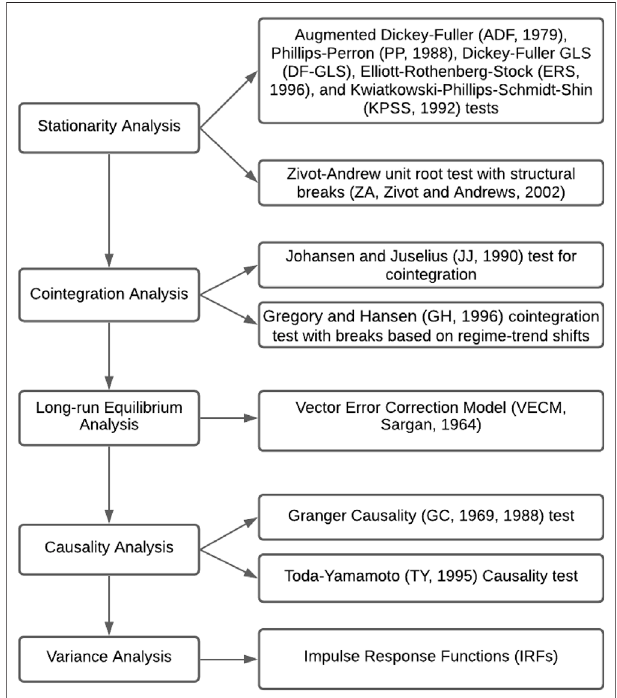
FIGURE 2 | Stepwise causality methodology. Source: our elaboration.